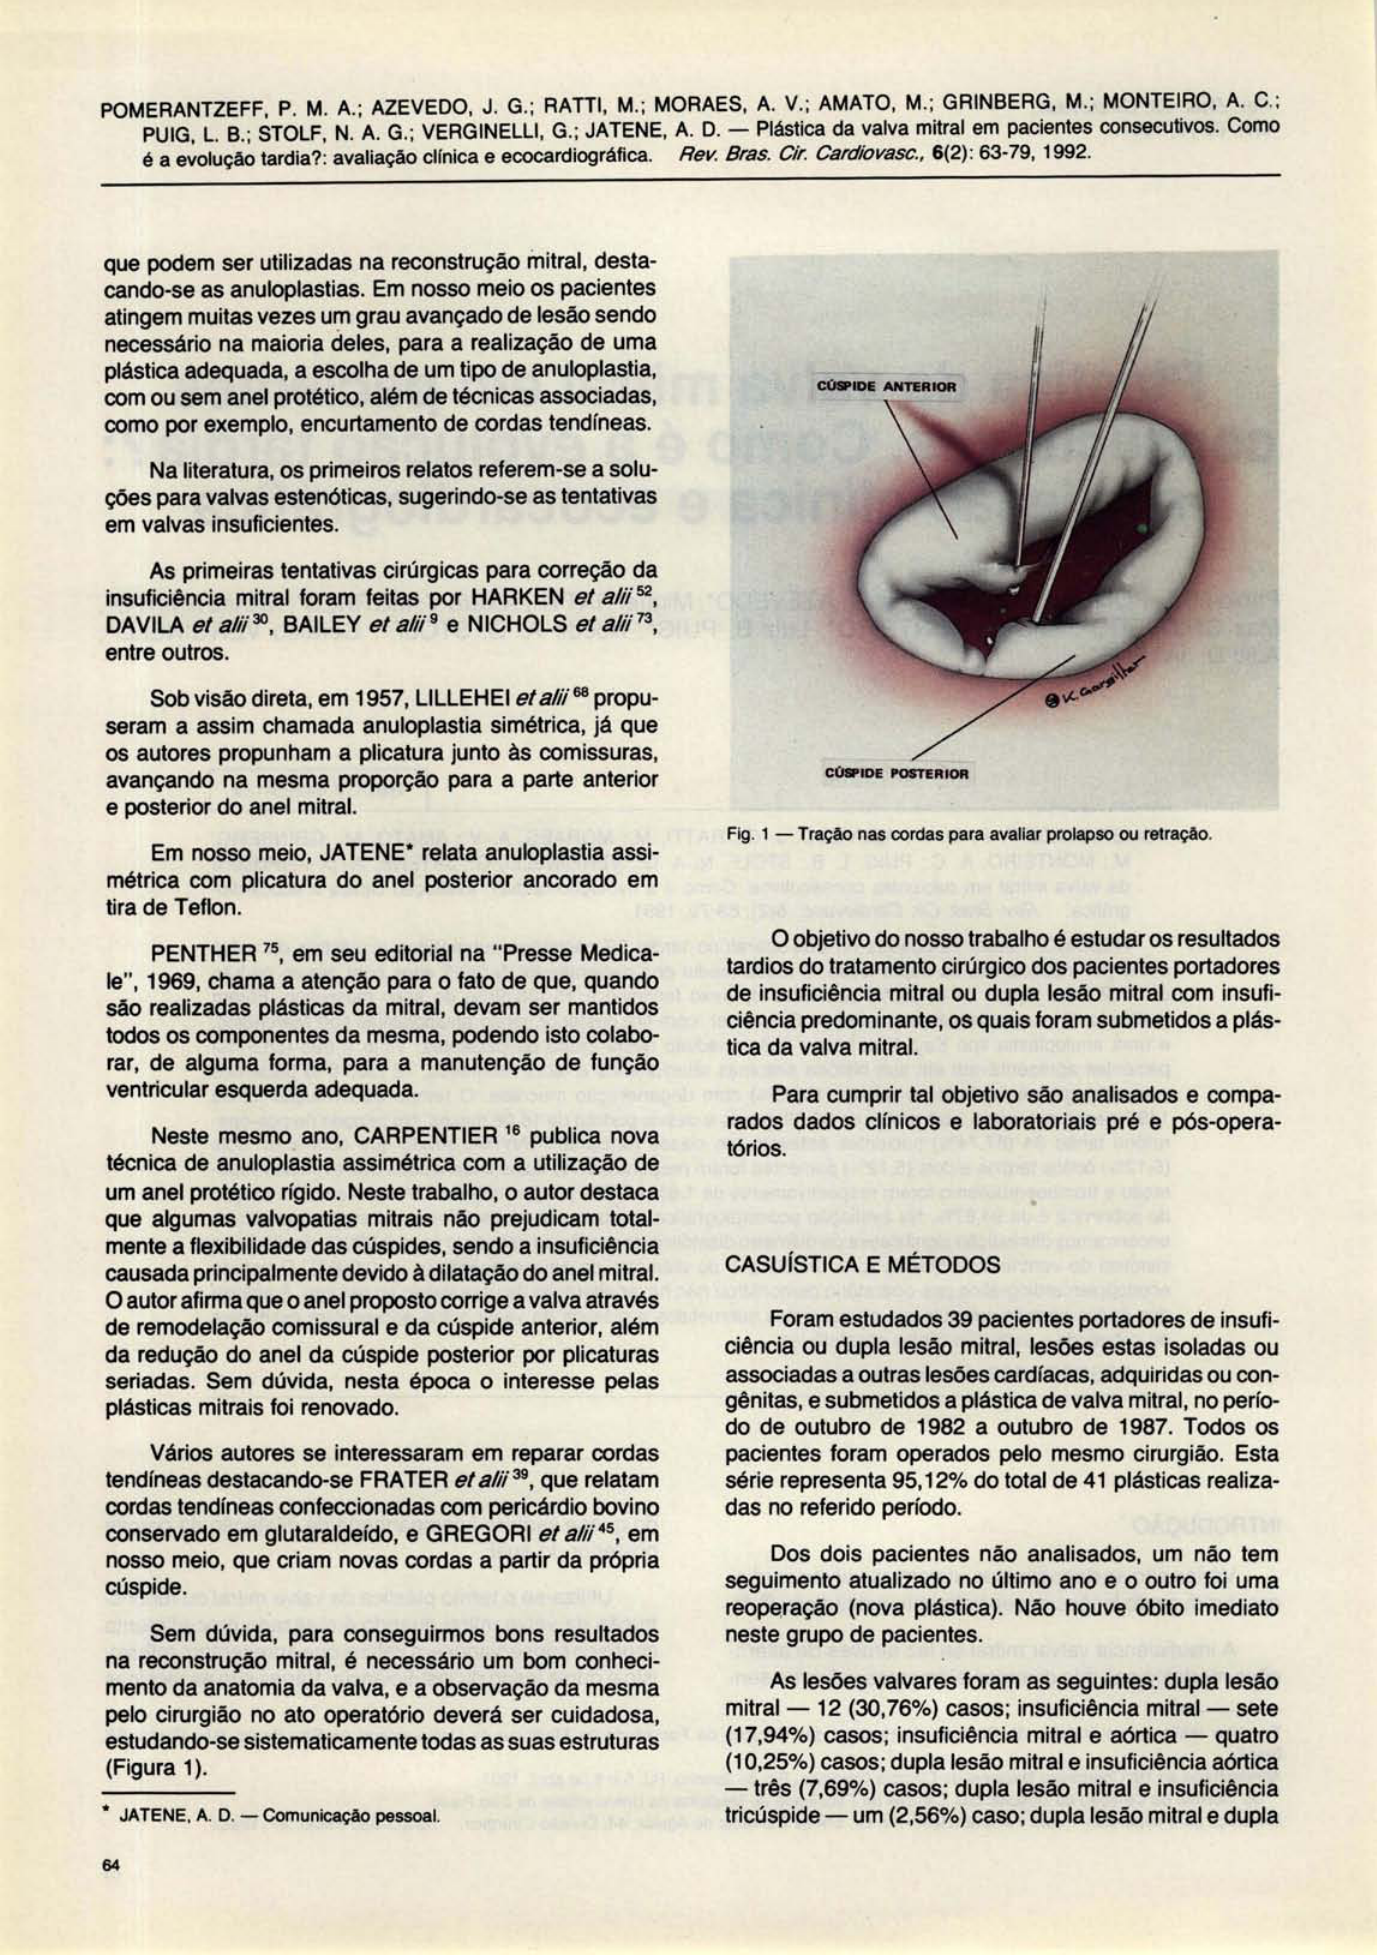
Fig. 1 - Tração nas cordas para avaliar prolapso ou